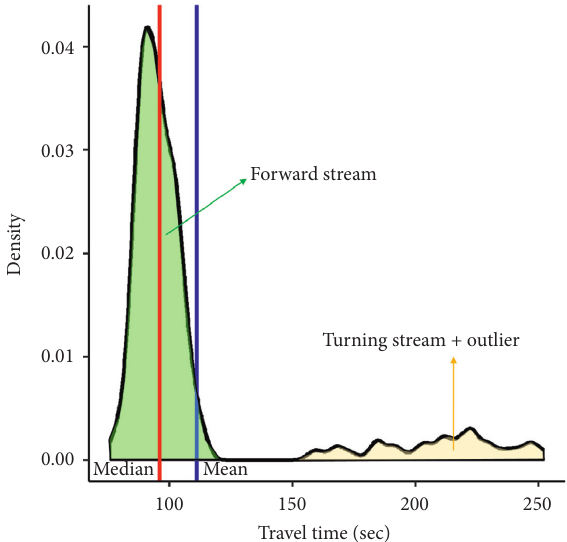
Figure 4: Bimodal shape of travel time data